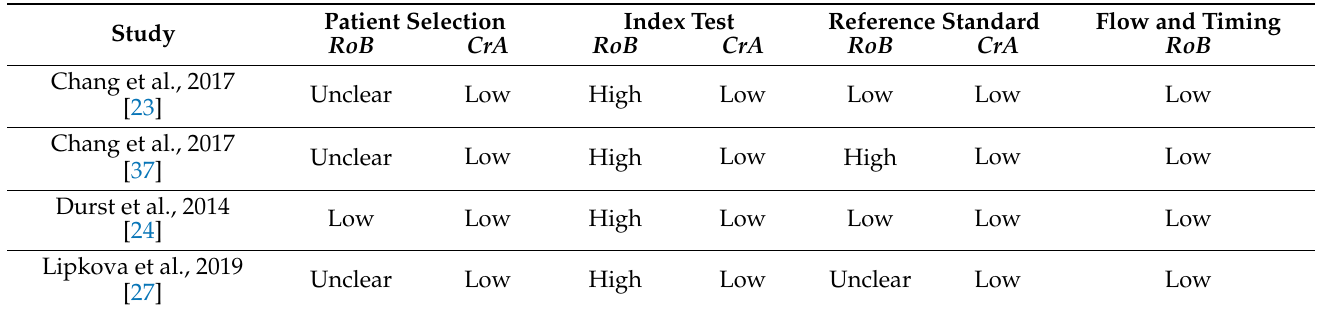
Table 4. QUADAS2. No independent diagnostic accuracy test of model